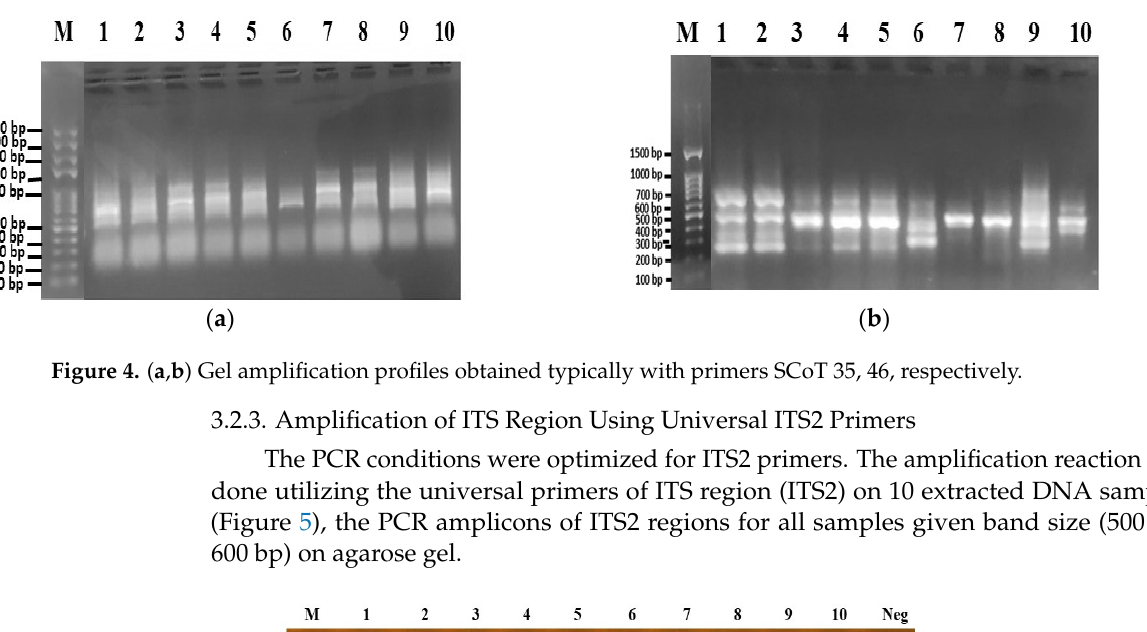
Figure 3. ( a – h ) Gel amplification profiles obtained typically with primers SCoT 7, 9, 10, 11, 14, 24, 28, and 32, respectively.